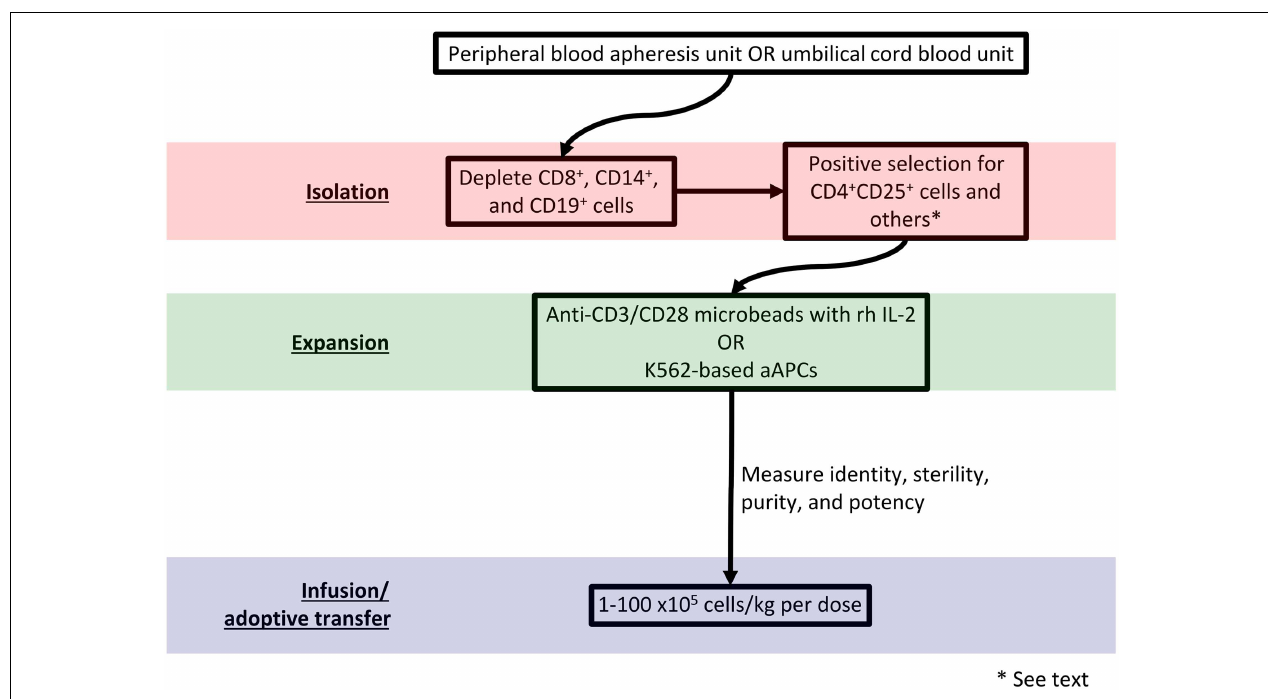
FIGURE 1 | Schematic of a strategy to isolate, expand, and infuseTregs